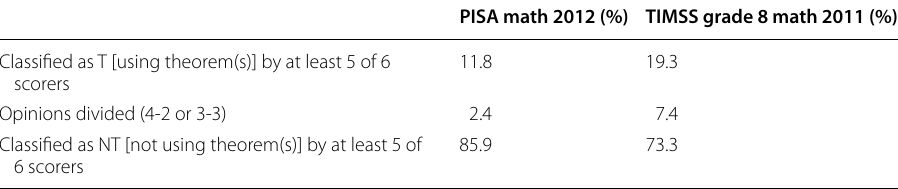
Table 2 Classification of PISA and TIMSS grade 8 items using the T/NT dichotomy, in per- centages of